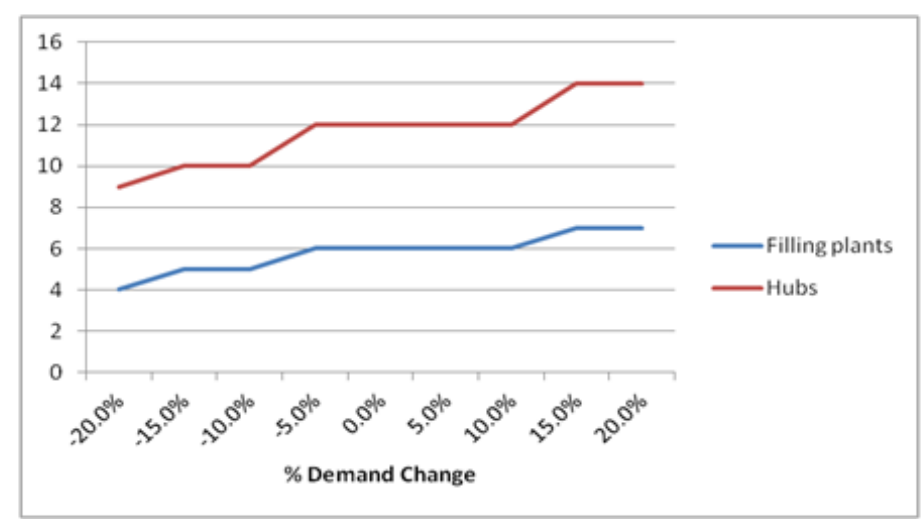
Figure 8. Demand Sensitivity Analysis for test case